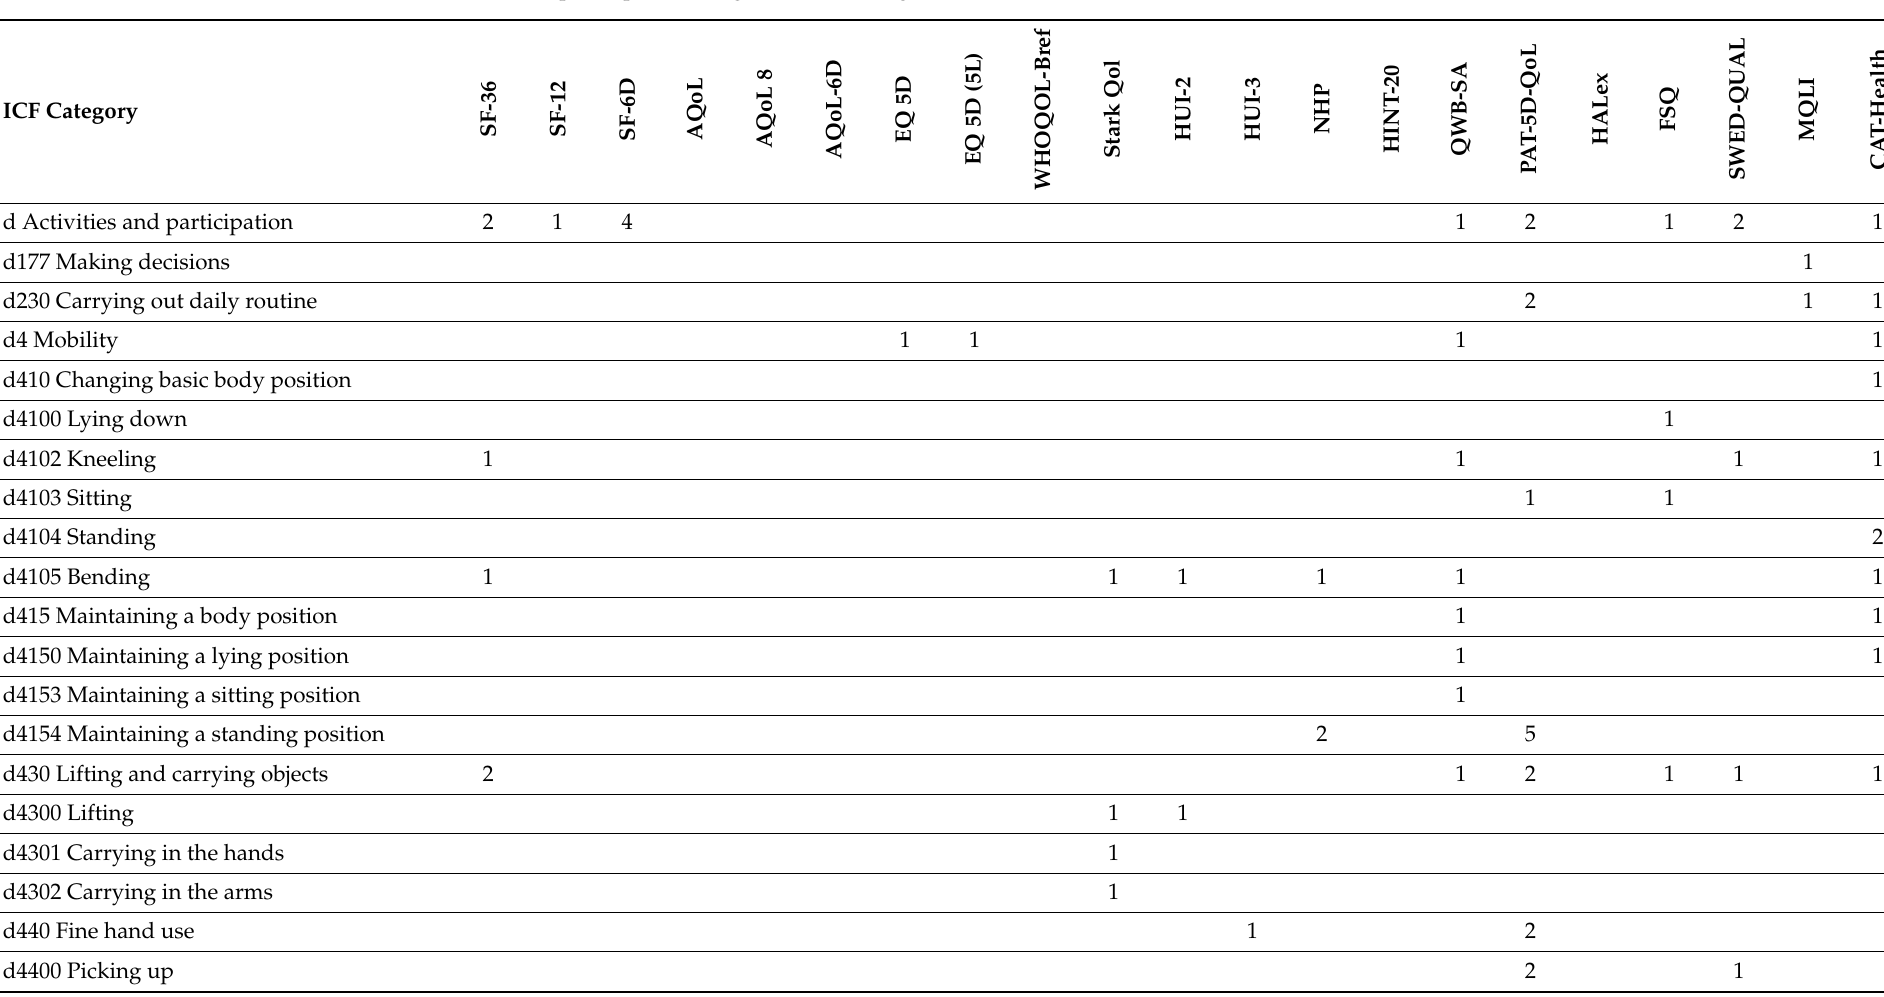
Table A1. Activities and participation categories ICF linking of HRQOL